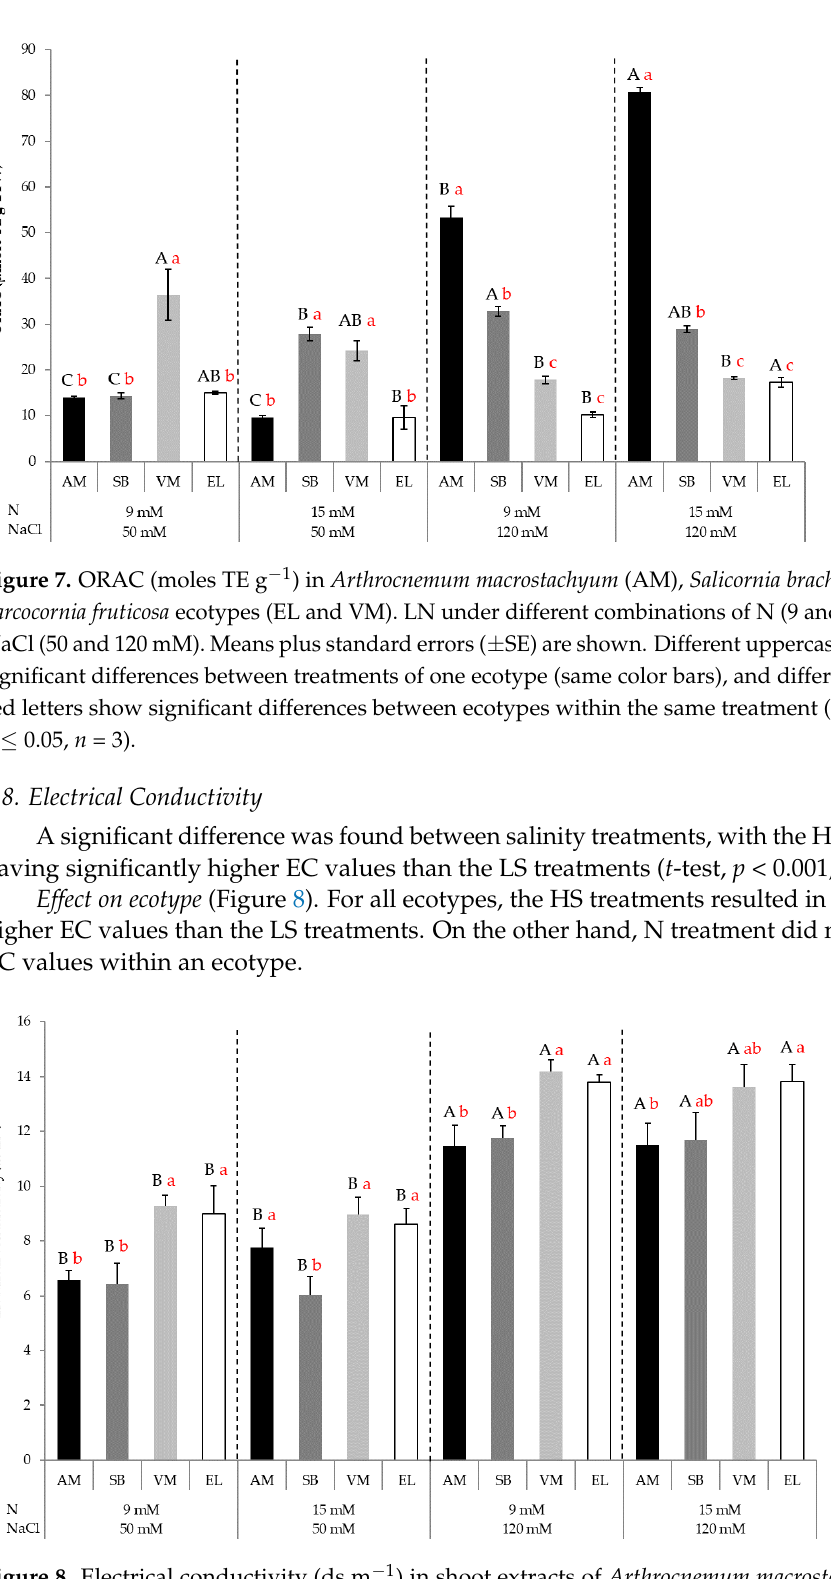
Figure 8. Electrical conductivity (ds m − 1 ) in shoot extracts of Arthrocnemum macrostachyum (AM), Salicornia brachiata (SB), and Sarcocornia fruticosa ecotypes (EL and VM). LN under different combi- nations of N (9 and 15 mM) and NaCl (50 and 120 mM). Means plus standard errors (±SE) are shown. Different uppercase letters show significant differences between treatments of one ecotype (same color bars), and different lowercase red letters show significant differences between ecotypes within the same treatment (Tukey’s HSD, p ≤ 0.05, n = 3).